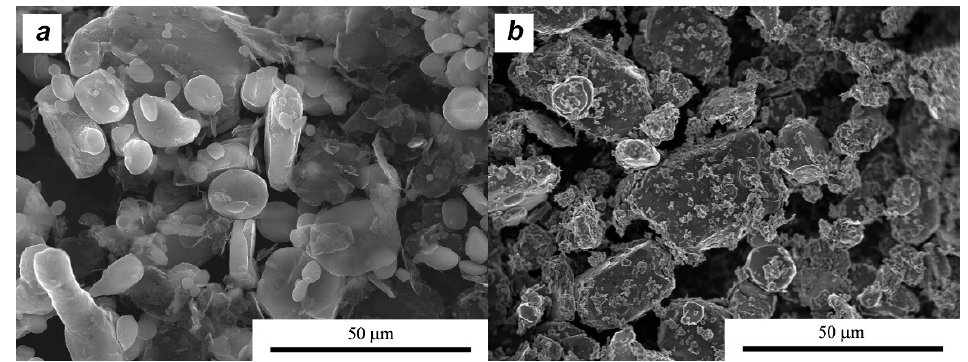
Figure 3. Morphology of granulated powder mixtures: ( a ) AA6061 + MLG 10 vol %; ( b ) AA6061 + MoS2 10 vol %.